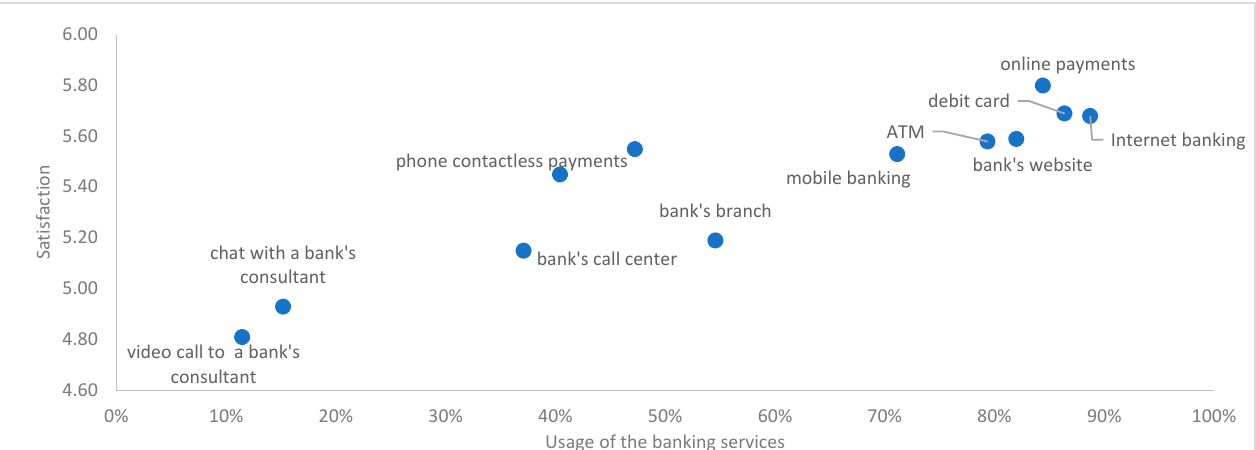
Figure 2. Satisfaction with and use of the banking services in different channels, 1Q 2021. Source: own computation based on data from ZBP 2021.